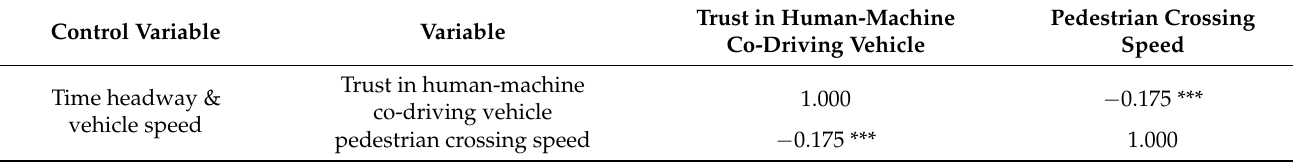
Table 2. Analysis of the partial correlation between trust in human-machine co-driving vehicles and pedestrian crossing speed.